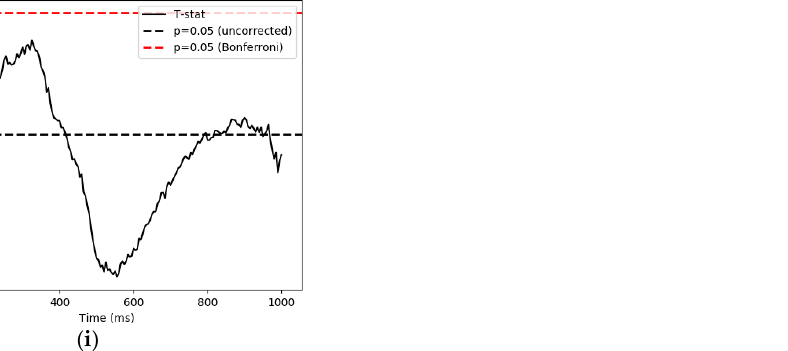
Figure 6. This section shows the statistical results of significant pattern differences between condi- tions. The x -axis is time, while the y -axis is t score. ( a ) famous and scrambled pairing (FS), IMF4; ( b ) unfamiliar and scrambled pairing (US), IMF4; ( c ) famous and unfamiliar pairing (FU), IMF4; ( d ) famous and scrambled pairing (FS), IMF5; ( e ) unfamiliar and scrambled pairing (US), IMF5; ( f ) fa- mous and unfamiliar pairing (FU), IMF5; ( g ) famous and scrambled pairing (FS), IMF6; ( h ) unfamiliar and scrambled pairing (US), IMF6; ( i ) famous and unfamiliar pairing (FU),